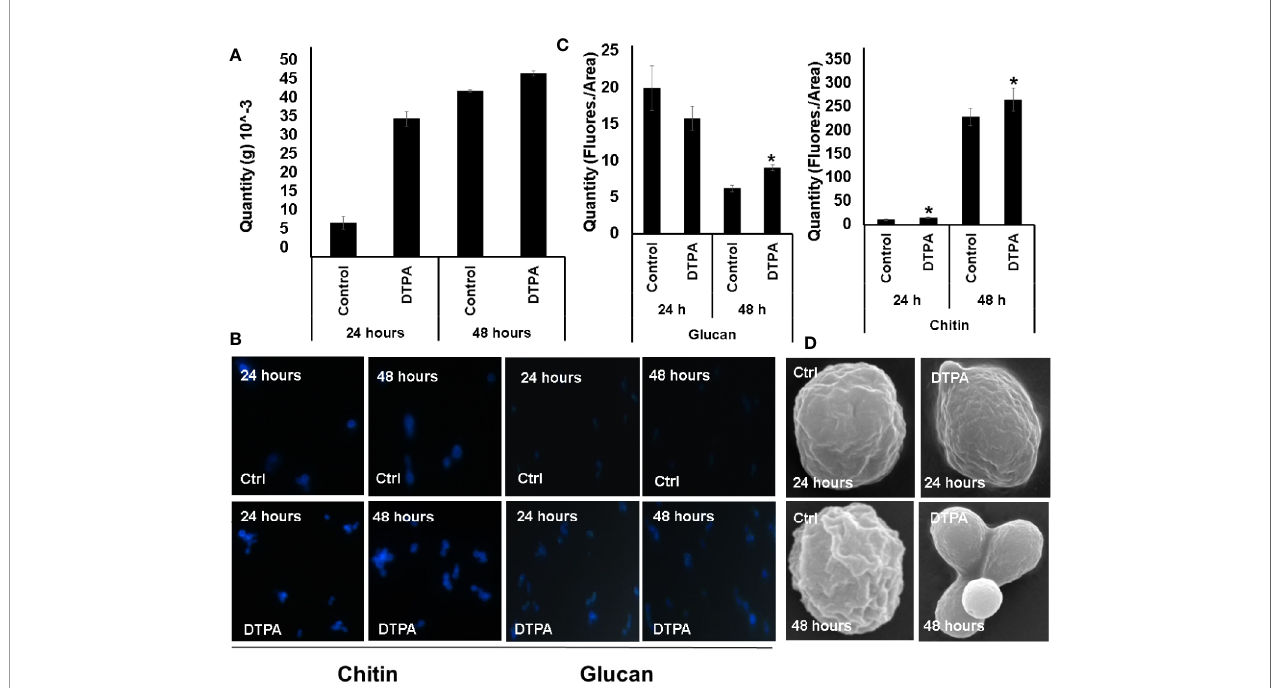
FIGURE 7 | Effect of Zn availability on H. capsulatum cell wall carbohydrates. (A) Dosage of total carbohydrate in H. capsulatum cells during zinc deprivation. (B) Fluorescence microscopy H. capsulatum grown under control and DTPA conditions. Calco fl uor white and aniline blue were used to dosage chitin and glycan, respectively. (C) Measurement of glycan and chitin contents using fl uorescence intensity. (D) Scanning electron microscopy of H. capsulatum during zinc deprivation. All experiments were carried out in biological triplicates. The comparisons were made using the Student t test with *p ≤